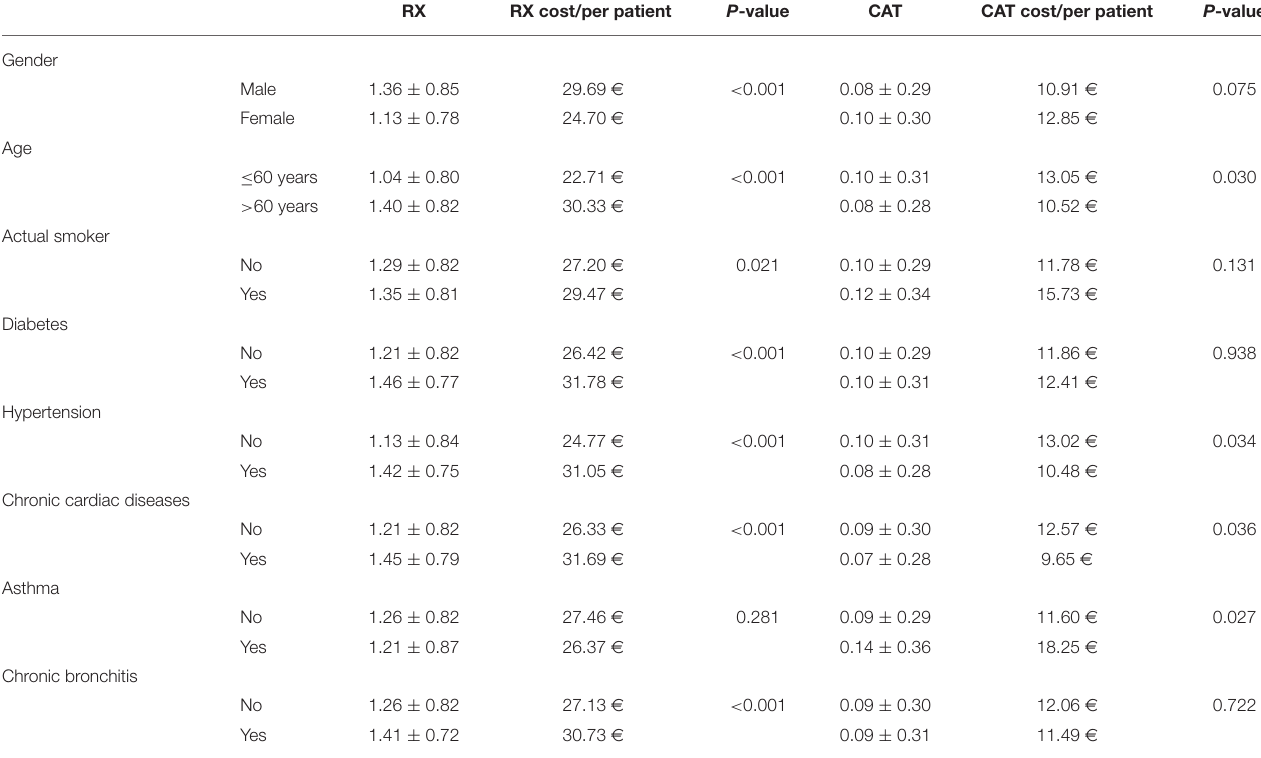
TABLE 4 | Relation between cost of diagnostic imaging and demographics and comorbidity variables. RX RX cost/per patient P -value CAT CAT cost/per patient P